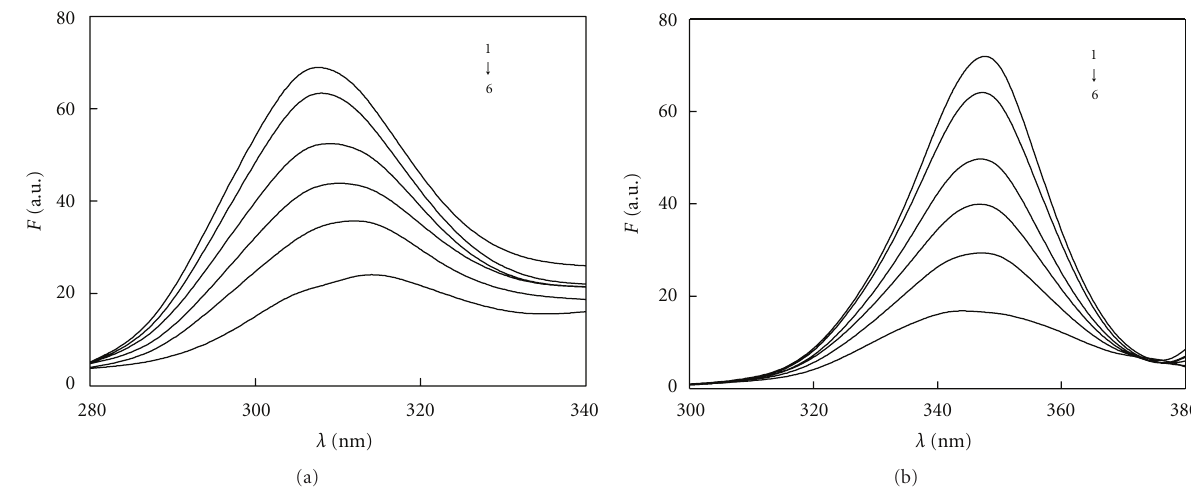
Figure 7: Synchronous fluorescence spectra of BSA-Avelox system C BSA = 1.0 × 10 − 6 M, 1 ∼ 6 C Avelox = (0.0, 2.0, 6.0, 10.0, 15.0, 25.0) × 10 − 6 M; (a) Δ λ = 15 nm, (b) Δ λ = 60 nm; T = 293